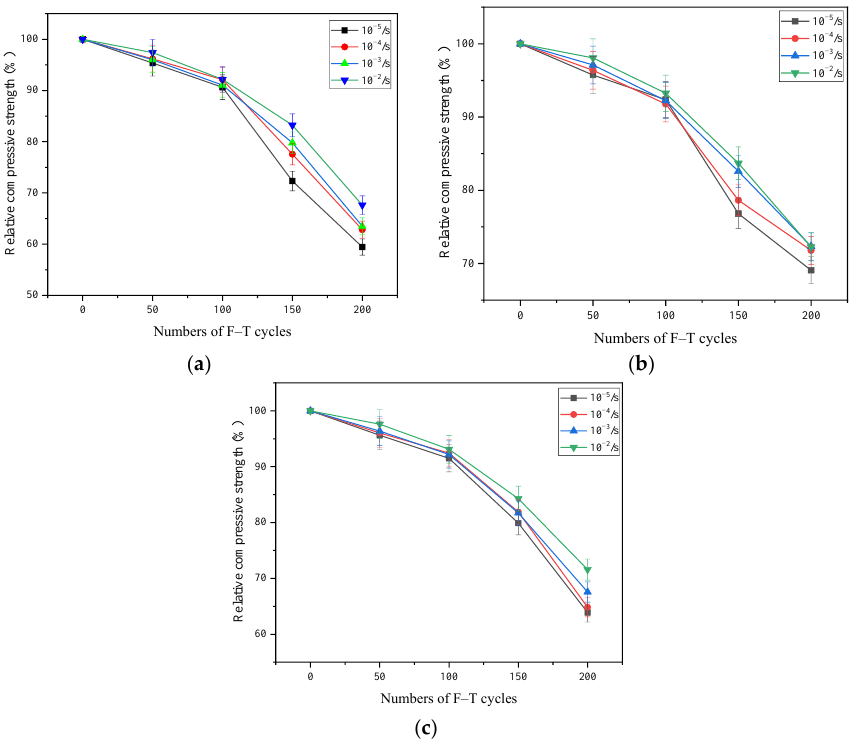
Figure 6. Relative compressive strength of concrete specimens with 5 MPa confining pressure under different numbers of F – T cycles. ( a ) SF0, ( b ) SF10 and ( c ) SF20.